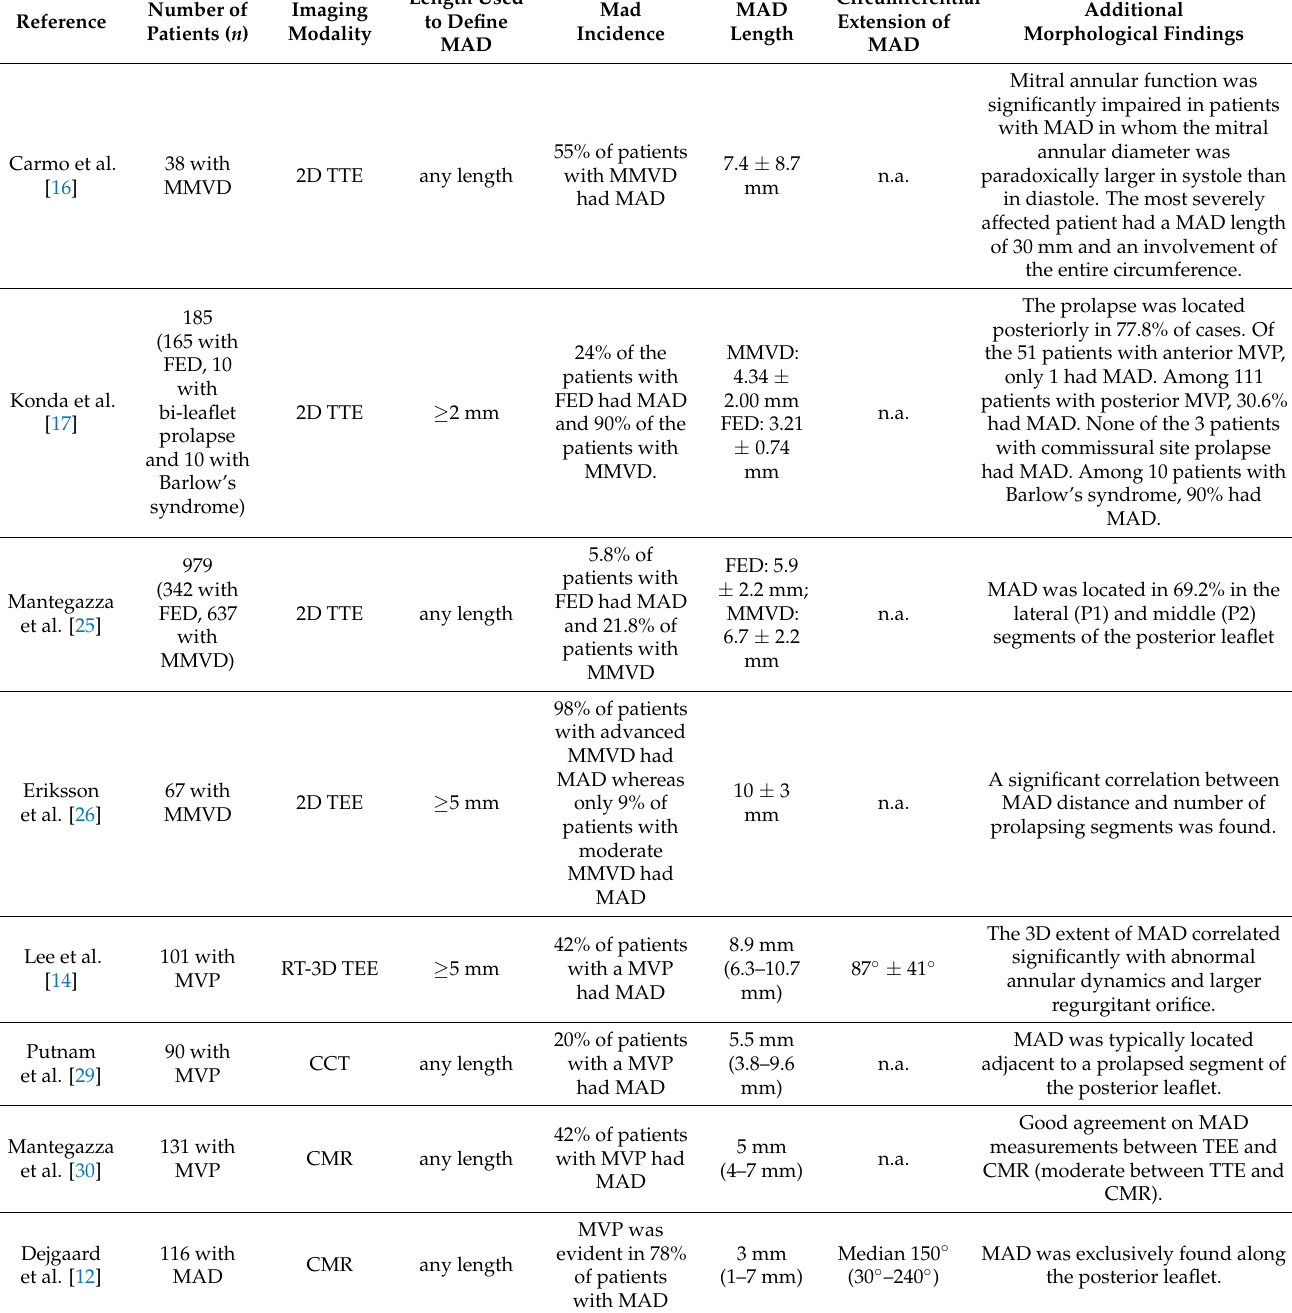
Table 1. Incidence of a MAD using different imaging